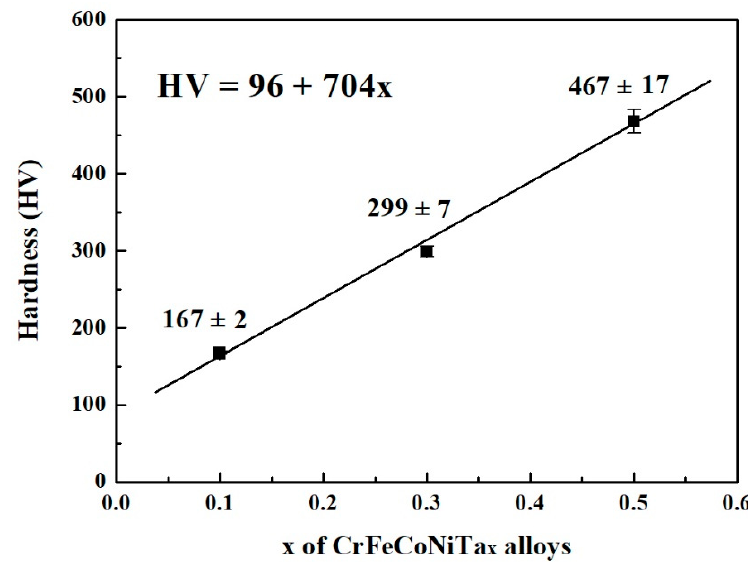
Figure 4. The relationship between the hardness and Ta content of as-cast CoCrFeNiTa x alloys. The load was 19.6 N.